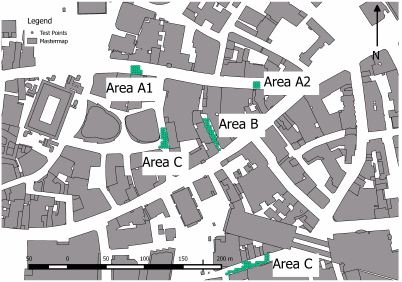
Figure 5: All 121 grid points tested, distributed over the area